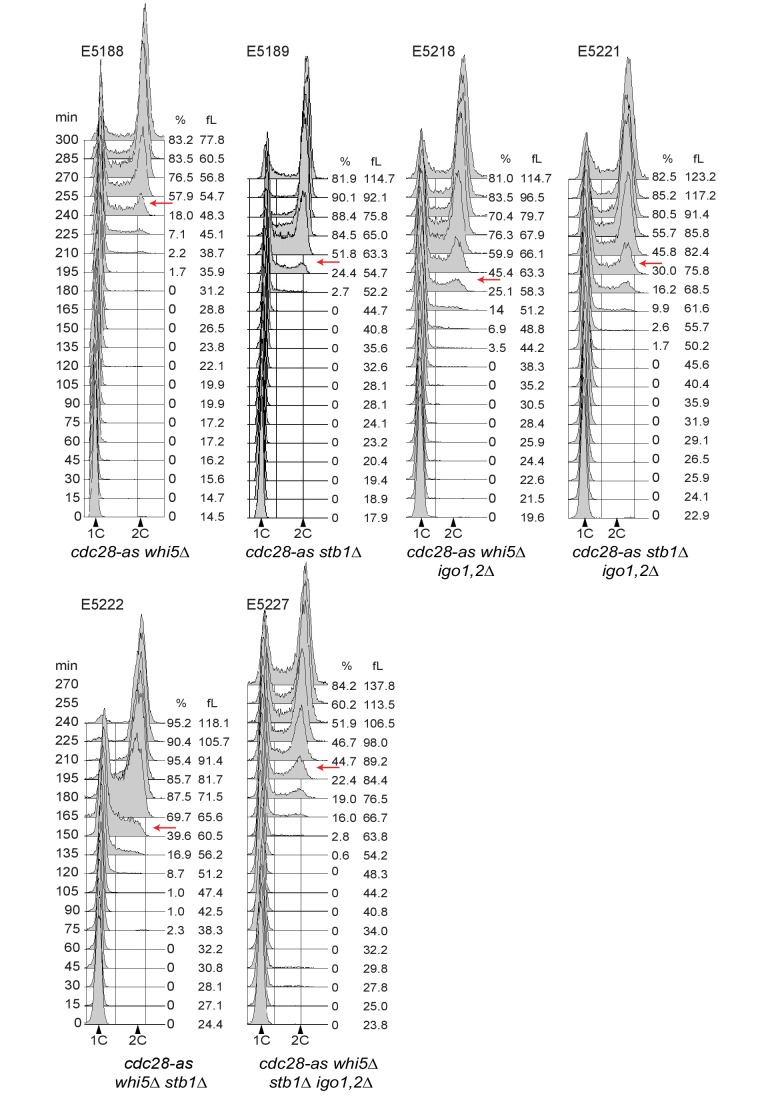
Cell cycle progression determined by FACS analysis of DNA content of elutriated early cells of the indicated genotype released in SC-D at 30°C.The peak cell size (in fL) and the budding index are given for each time point. BI, Budding index. The red arrow indicates when half of cells have budded. Elutriations were done three to six times independently for each strain; one example is shown (corresponding to Figure 4C).